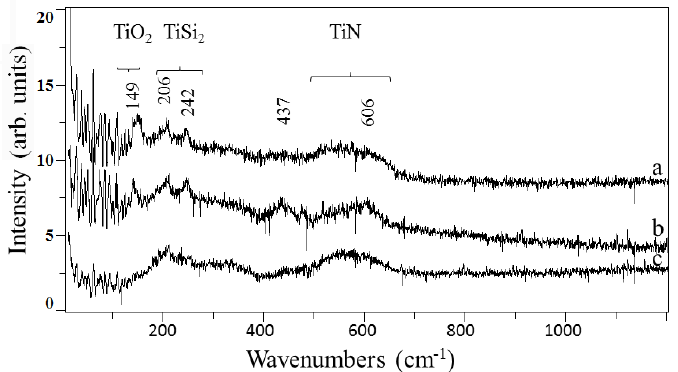
Figure 6. Raman scattering spectra of Ti films, 250 nm thick ( a ), and 500 nm thick ( b ), heated at 600 °C and processed in (Ar ‐ 33%N 2 ‐ 1%H 2 ) plasma for 30 min, and Ti films, 500 nm thick ( c ), heated at 600 °C and processed in (Ar ‐ 33%N 2 ‐ 1%H 2 ) plasma for 3